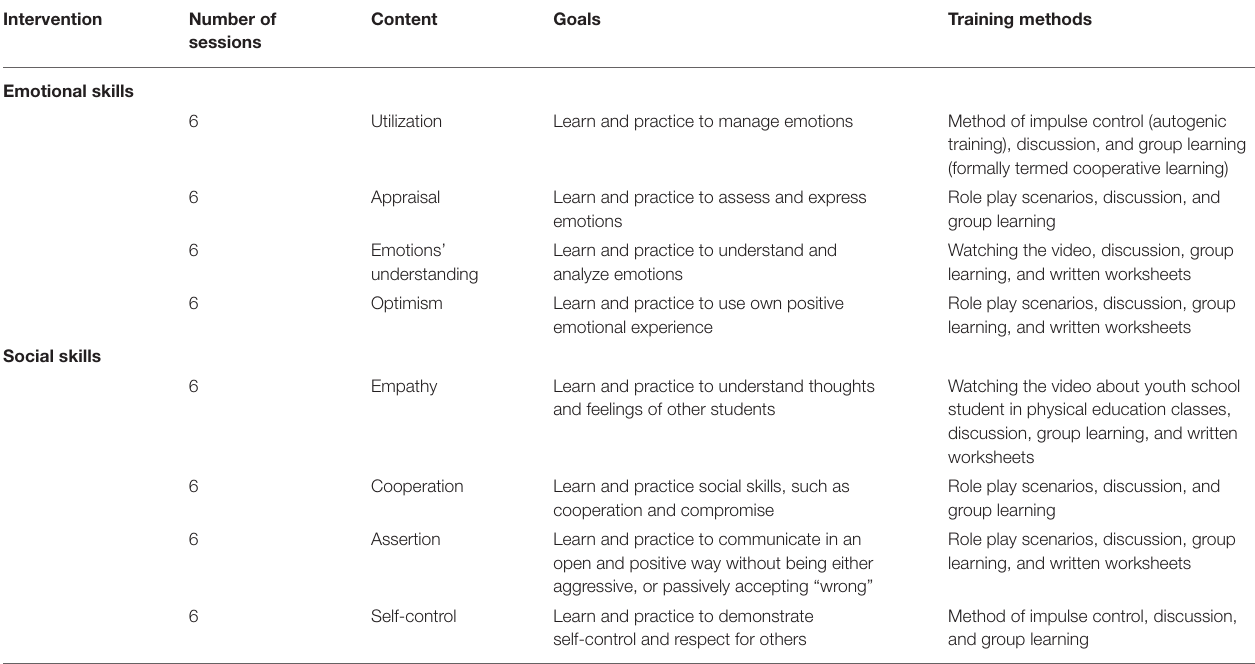
TABLE 1 | Description of social-emotional skills training program for youth school students in physical education classes.